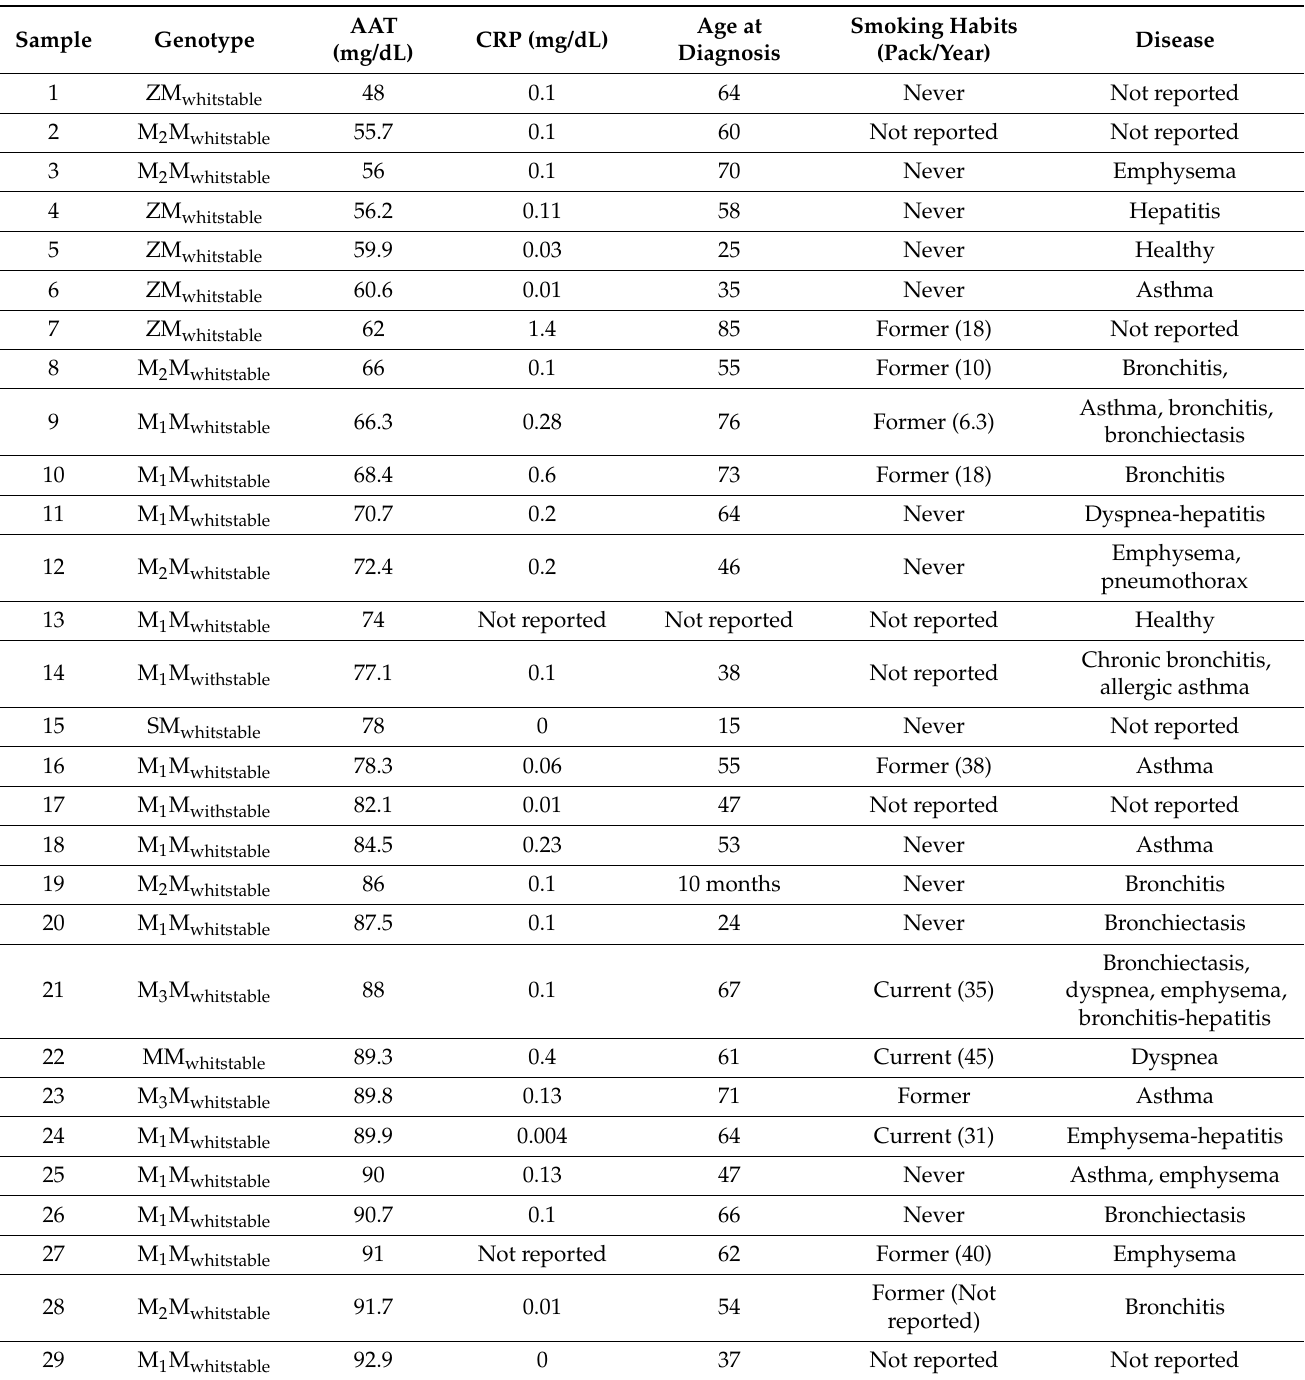
Table 2. Clinical data of patients carrying the M whitstable rare